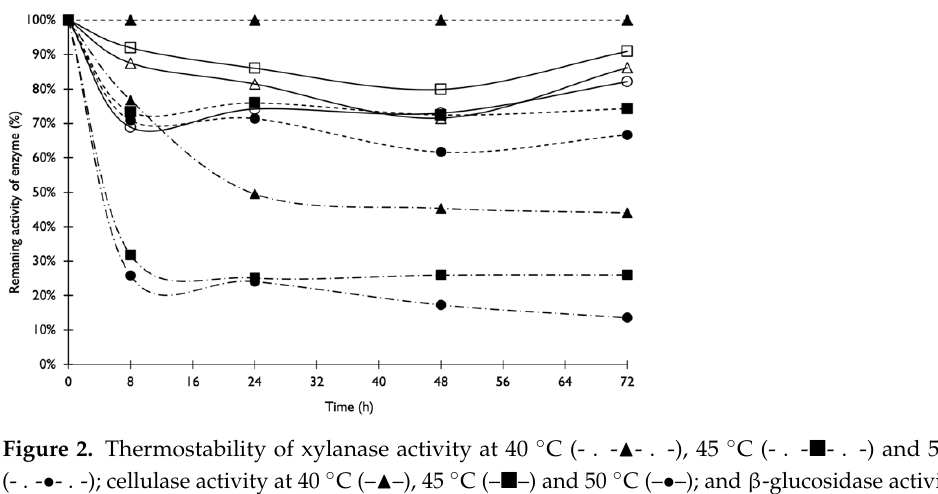
Figure 2. Thermostability of xylanase activity at 40 °C (- . - ▲ - . -), 45 °C (- . - ■ - . -) and 50 °C (- . - ● - . -); cellulase activity at 40 °C (-- ▲ --), 45 °C (-- ■ --) and 50 °C (-- ● -- ); and β -glucosidase activity at 40 °C ( ), 45 °C ( □ ) and 50 °C ( ○ ).